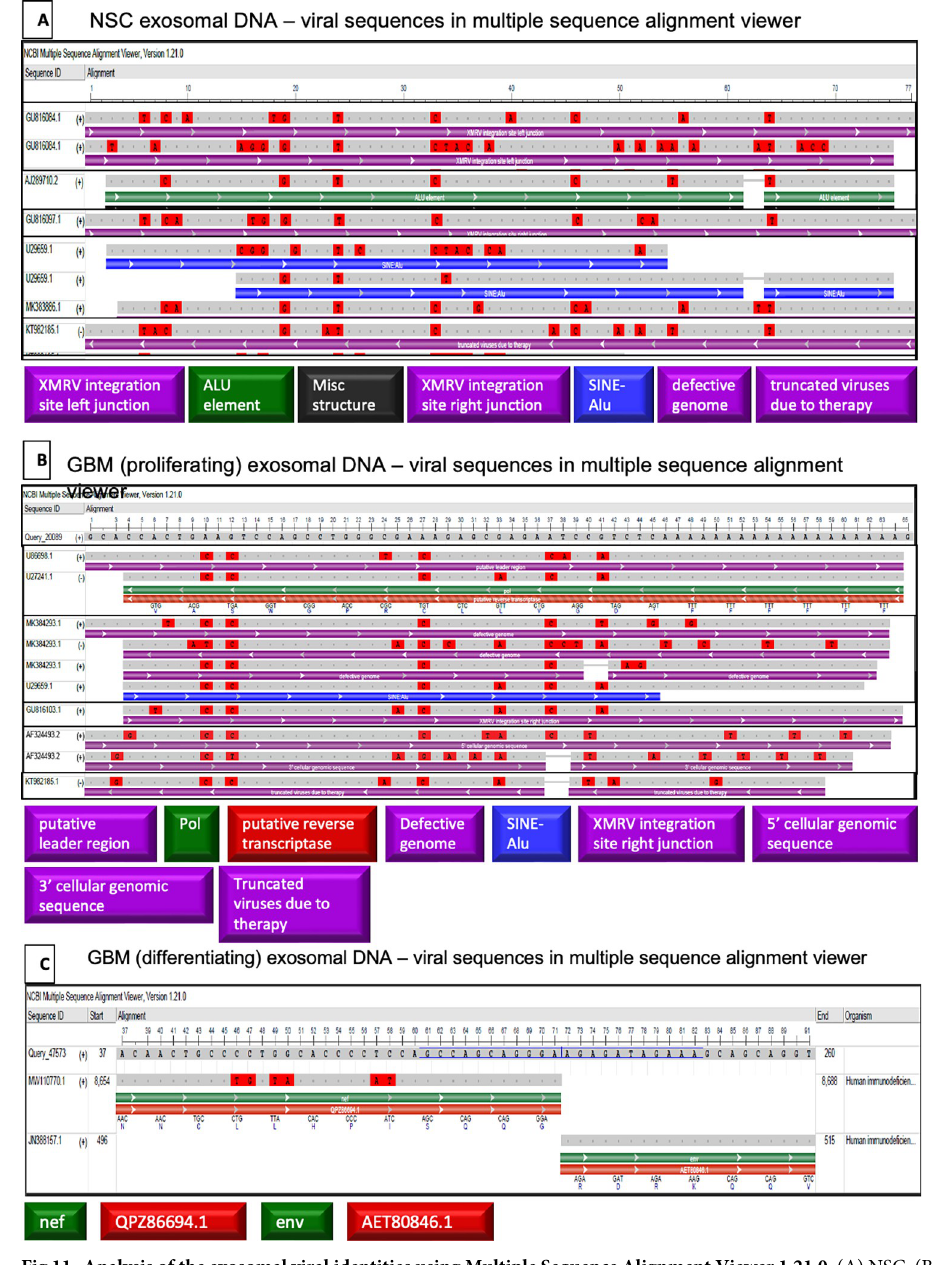
Fig 11. Analysis of the exosomal viral identities using Multiple Sequence Alignment Viewer 1.21.0. (A) NSC, (B) GBM—proliferating and (C) differentiating (CD133 - ) GBM exosomal